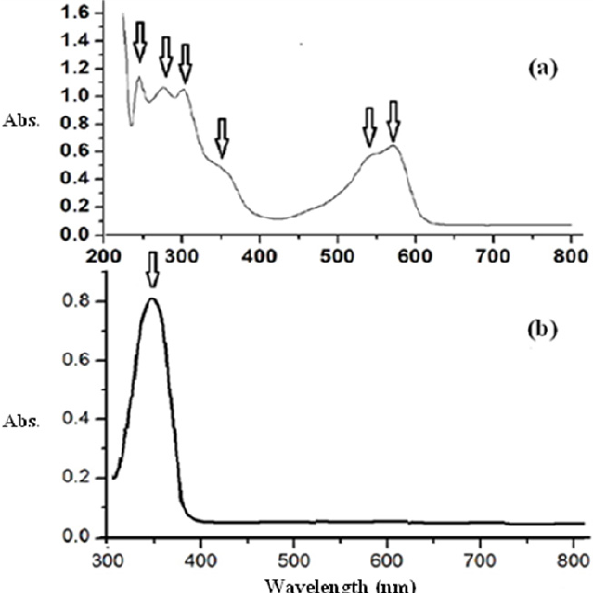
Figure 3. UV-vis spectrum of the desired complex ( a ) and NiO nanoparticles dissolved in water at room temperature ( b